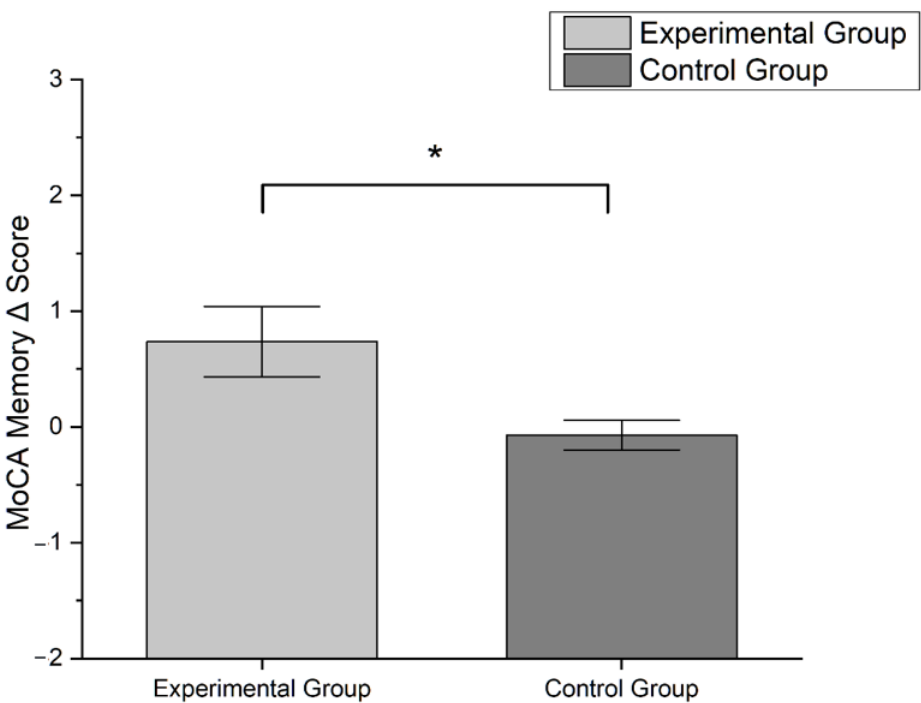
Figure 2. Bar-graph showing differences in Δ MoCA memory sub-scale score between groups according to the formula: Δ score = T1 score − T0 score. Error bars represent standard error (* p < 0.05; Mann–Whitney U test).